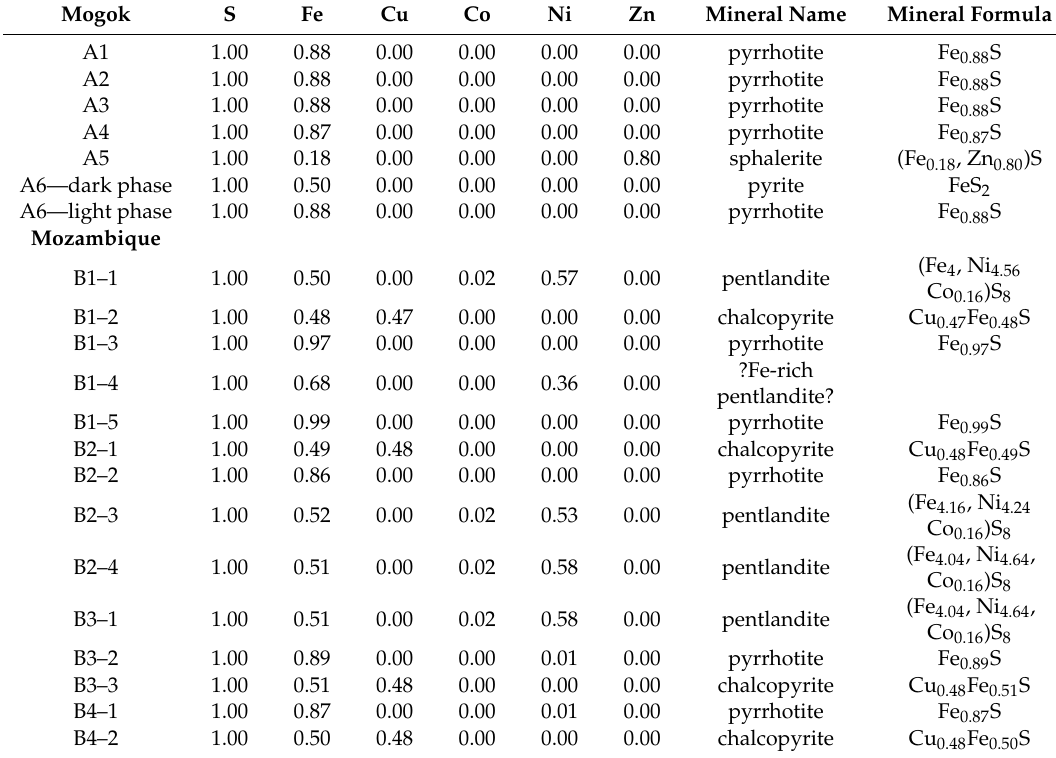
Table 4. Molar percentages normalized to